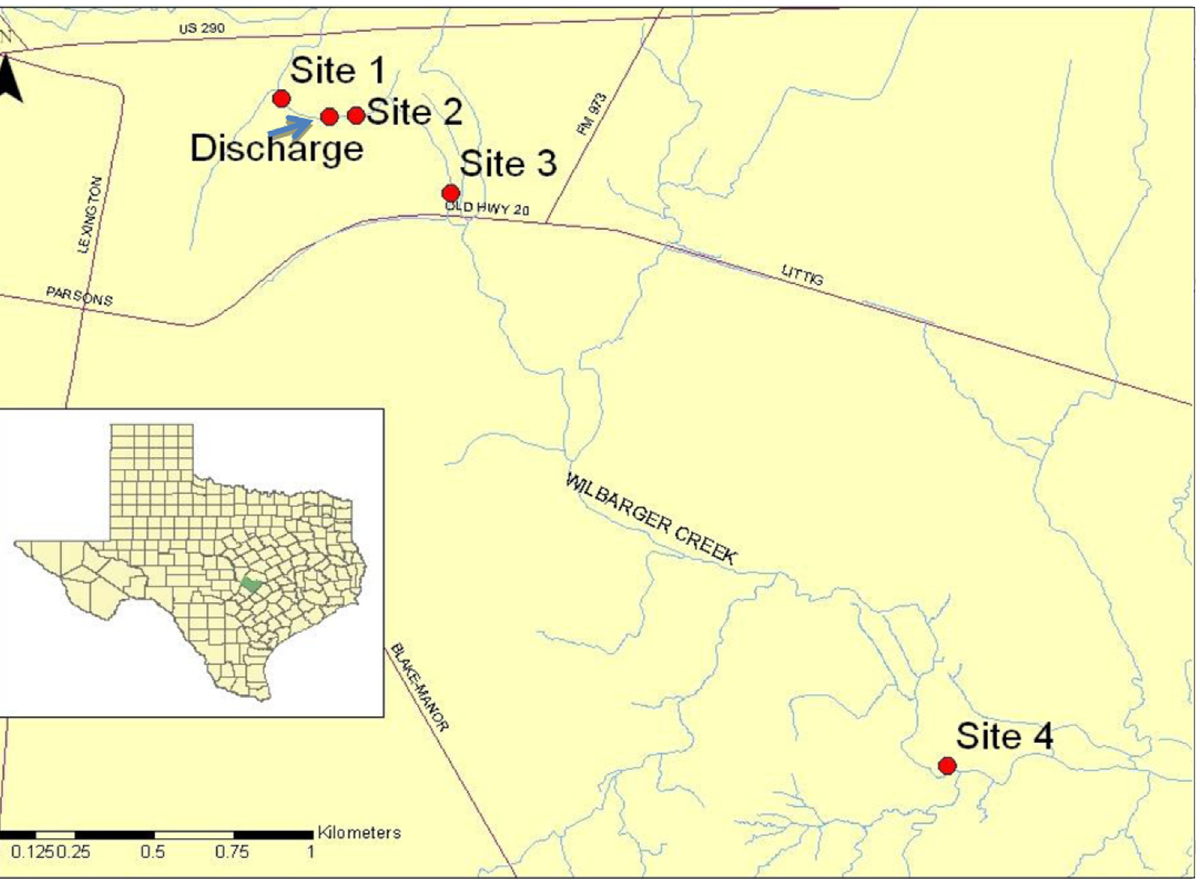
Fig 1. Map showing locations of the four study sites in relation to the Wilbarger wastewater treatment plant (WWTP) discharge (City of Manor, Travis County, Texas, 30°20'47.23"N, 97°32'56.74"W). Inset shows the location of Travis County (shown in green) in the state of Texas. Discharge indicates the discharge of the WWTP effluent.